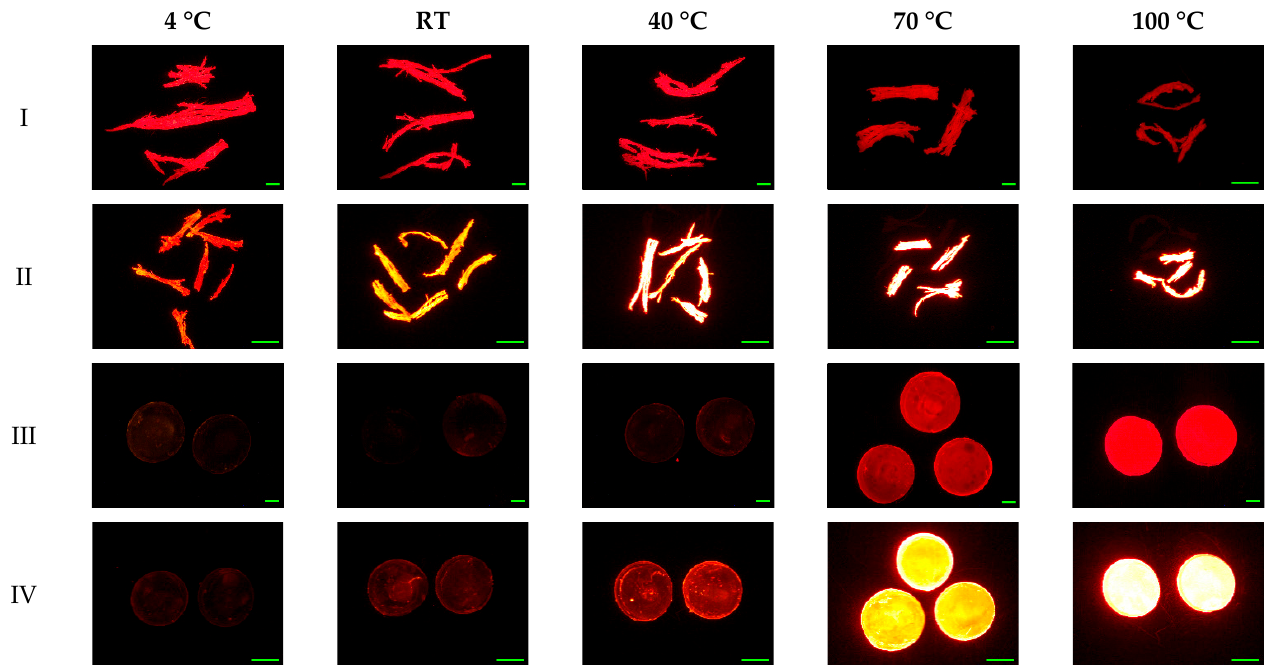
Figure 2. Red fluorescence microscope images of ( I ) PA6-w fragments stained by 55 mg/mL Rit pink dye, ( II ) PA6-w stained by 2 µg/mL Nile red, ( III ) PVC.1 stained by 5 mg/mL iDye pink dye, and ( IV ) PVC.1 stained by 2 µg/mL Nile red at different temperatures for 3 h. Scale bar denotes 1 mm.